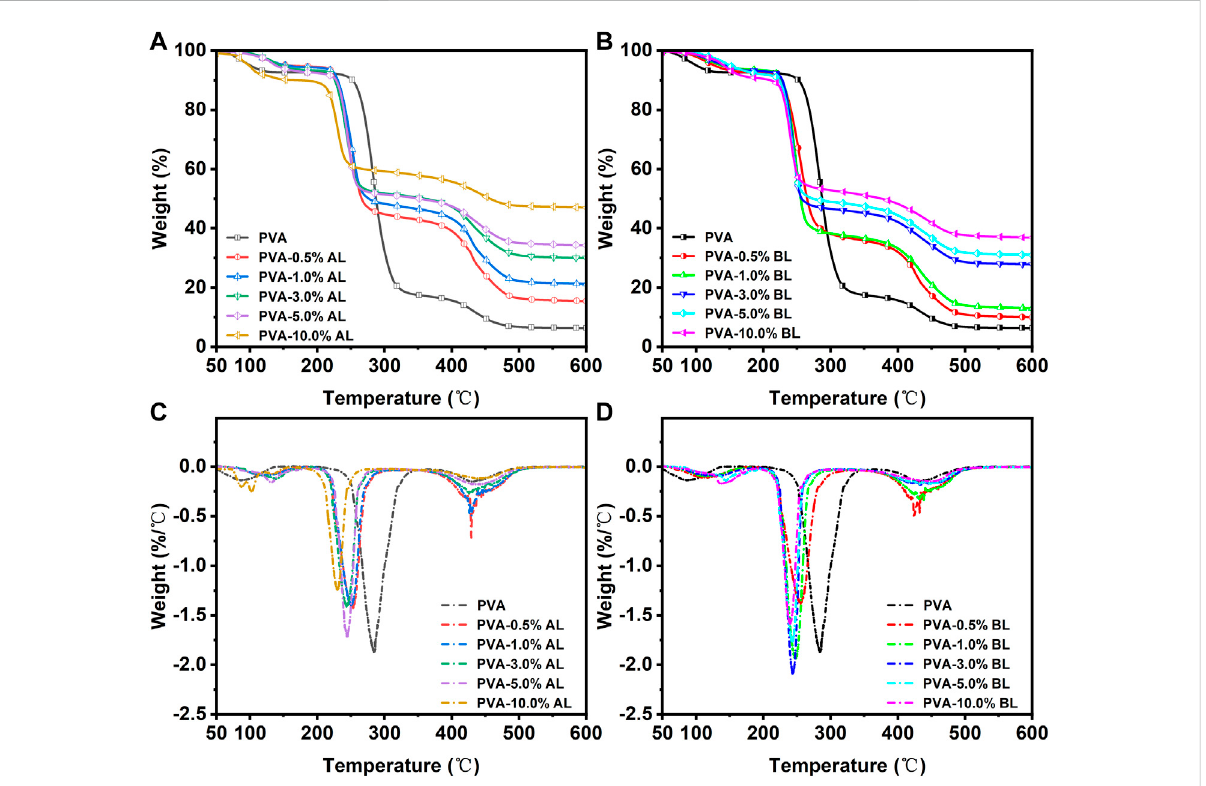
FIGURE 5 Thermal Stability of various composite fi lms. (A,C) present the TG and DTG spectra of PVA and PVA/AL fi lms; (B,D) present the TG and DTG spectra of PVA and PVA/BL fi